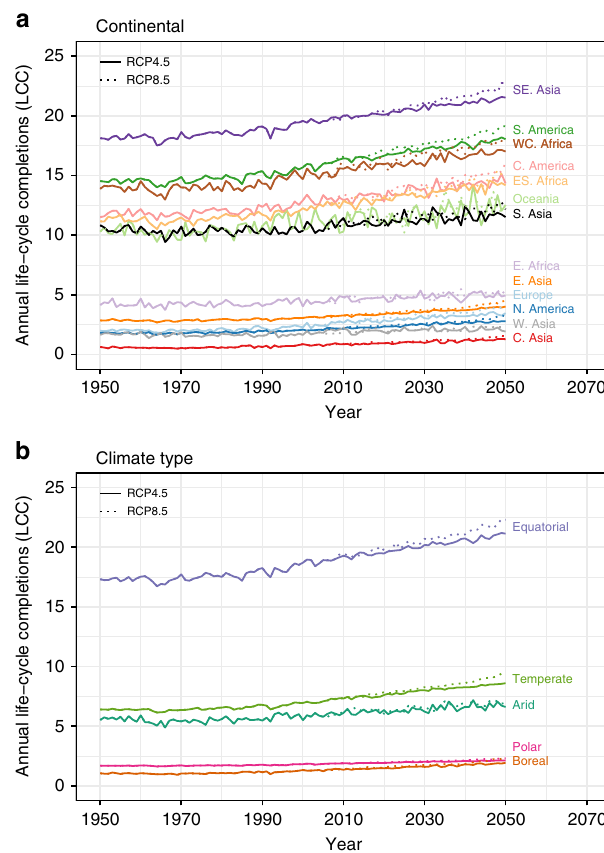
Fig. 3 Continental and climatic regional averages of annual LCC 1950 – 2050. The annual LCC at each location was averaged over continental regions ( a ) and climatic regions ( b ) between 1950 and 2050. Data were calculated for each year with two climatic scenarios — solid lines represent the LCC prediction under RCP 4.5 scenario and dotted lines are under RCP 8.5 scenario. Con fi dence intervals indicating variability due to the underlying GCMs are not shown here to avoid overplotting and retain clarity of the mean trends — see text for 95% CIs on percentage change statistics over the time series and Fig. 5 for CIs on seasonal